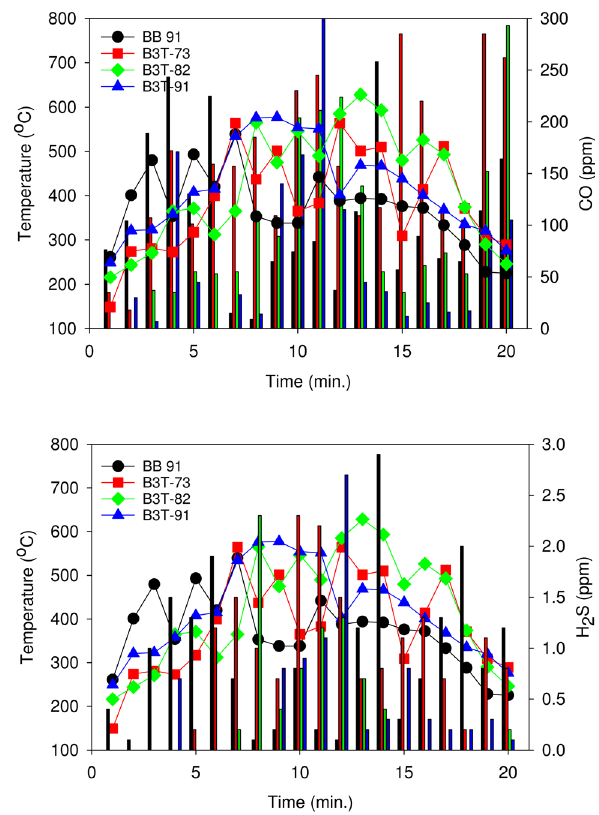
Fig. 9 Typical of temperature, CO content and H 2 S content profile of bio-coal briquettes combustion test as a function of